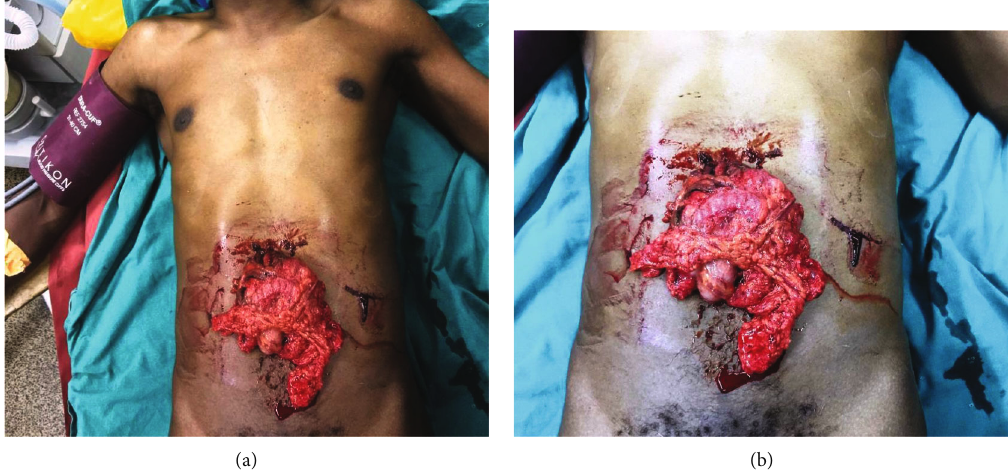
Figure 2: (a and b) Eviscerated omentum with transverse colon. Patient sustained penetrating abdominal injury from broken beer bottle.